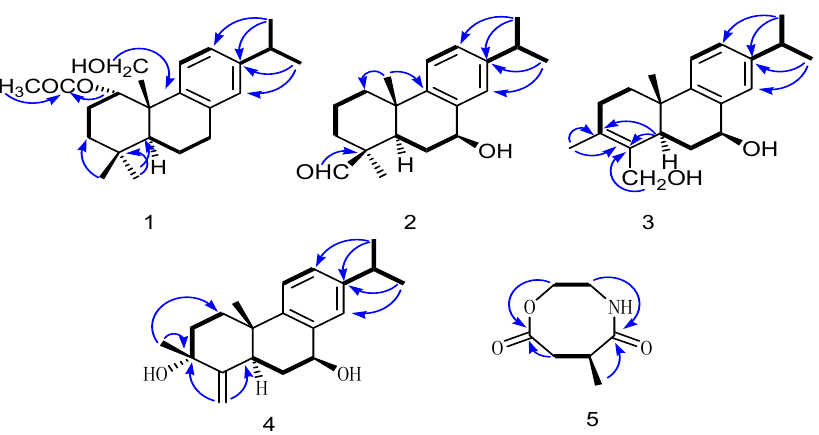
Figure 2. Key 1 H– 1 H COSY (in bolds) and HMBC (arrows) correlations of compounds 1 – 5 .